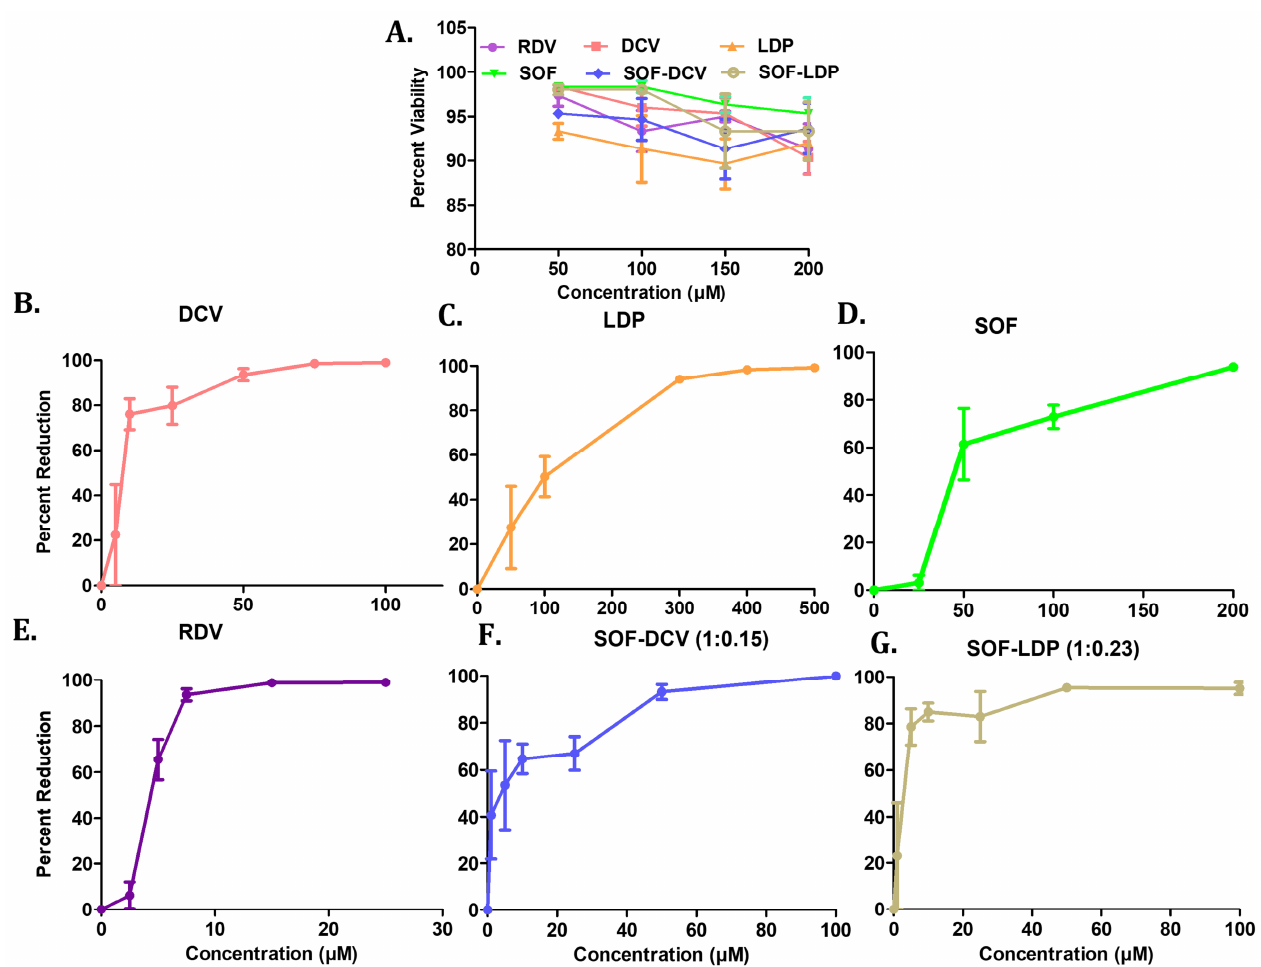
Figure 2. ( A ) Cytotoxicity of drug molecules was checked using MTT assay. Anti-viral activity of ( B ) DCV ( C ) LDP ( D ) SOF ( E ) RDV ( F ) SOF/DCV in 1:0.15 ratio and ( G ) SOF/LDP 1:0.23 ratio on Vero E6 cells in 96 well plates at 80% confluency. Graphs are represented as the percentage reduction of viral loads by qRT-PCR in infected cells with and without drug treatment. MTT: dimethylthiazolyl diphenyltetrazolium bromide; DCV: Daclatasvir; LDP: Ledipasvir; SOF: Sofosbuvir; RDV: Remdesivir.